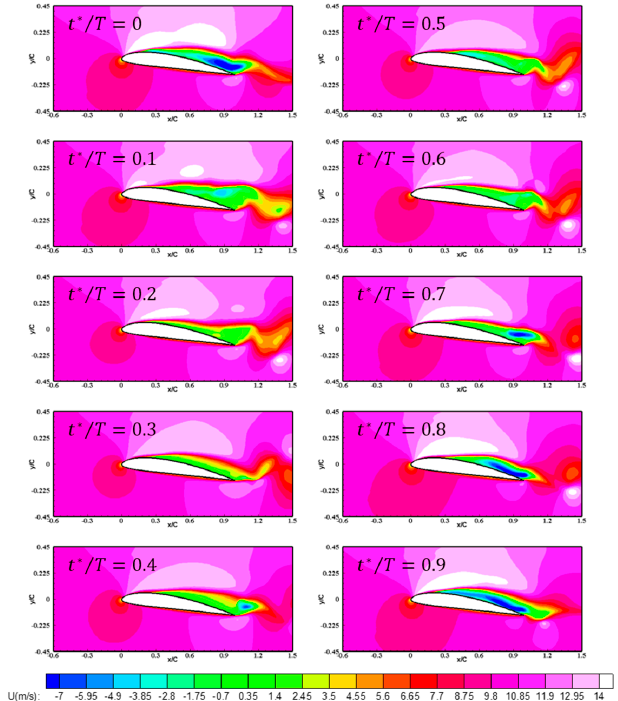
Figure 13. Time-variation of predicted x-directional velocity: full viscous case. Appl. Sci. 2018 , 8 , x FOR PEER REVIEW